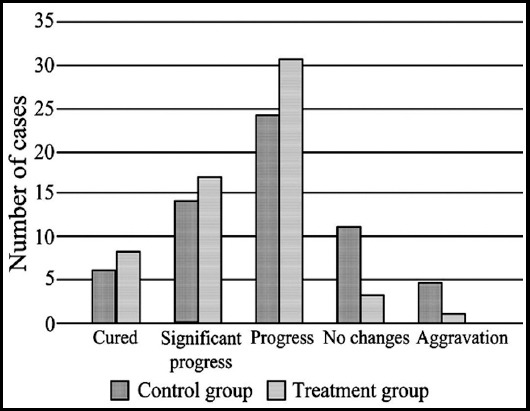
Clinical effect between the two groups.